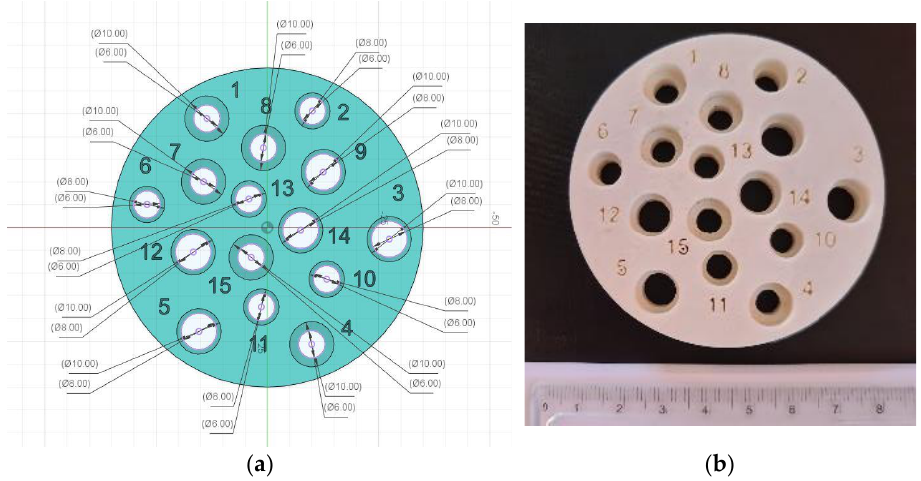
Figure 2. 3D CAD model of test part 1 ( a ); Example of a test part with counterbore vertical axis holes for the experiment 1 (specimen 16) ( b ).